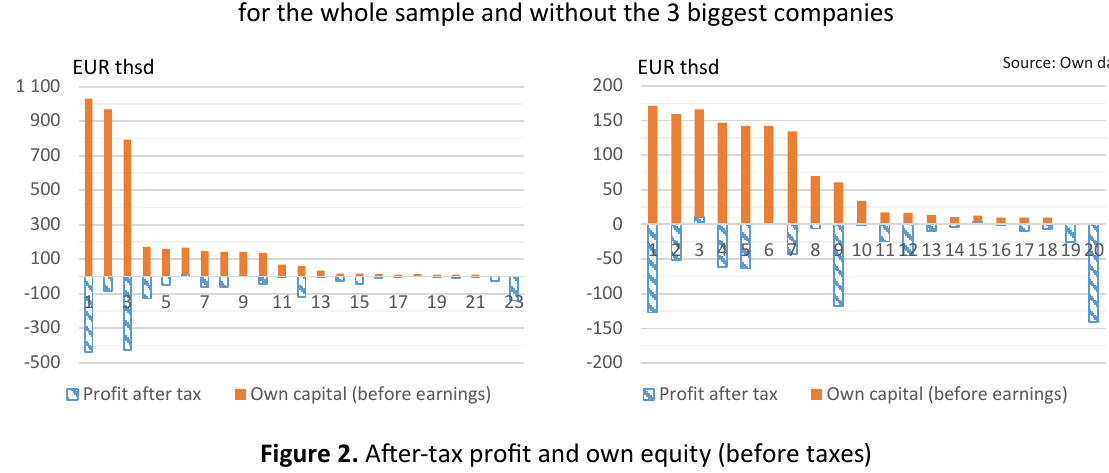
Figure 1. Total income in the year preceding the due